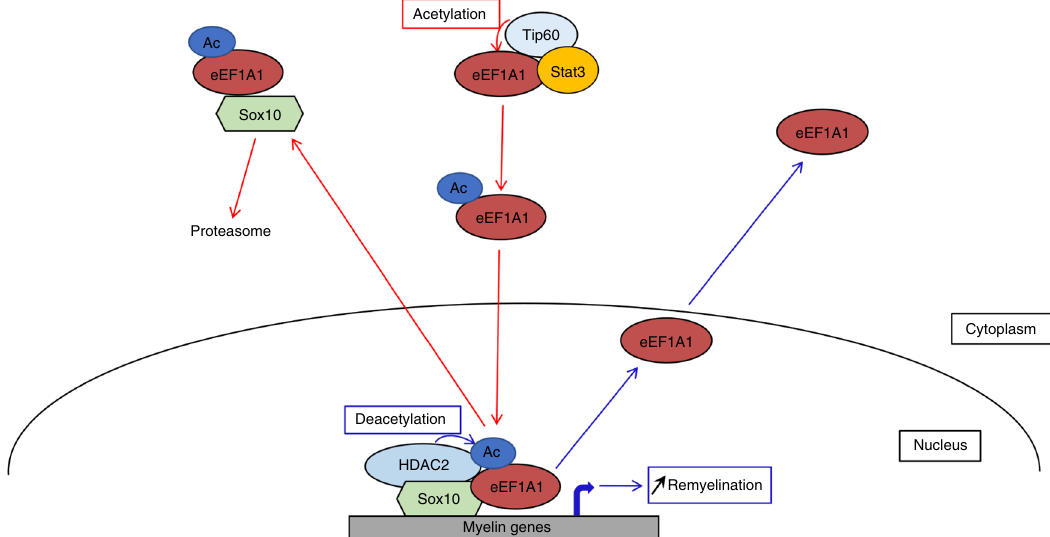
Fig. 6 Proposed mechanism of Ac-eEF1A1-dependent regulation of Sox10. Schematic representation of mechanisms controlling eEF1A1 acetylation- dependent Sox10 degradation and suggesting deacetylation-dependent